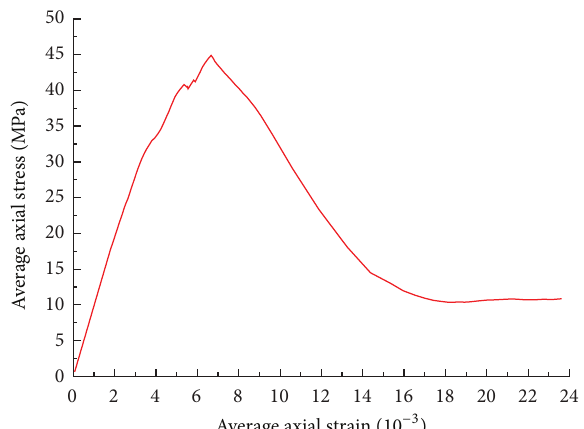
Figure 19: Average axial stress-strain around a pillar with width-to- height ratio = 2.5.